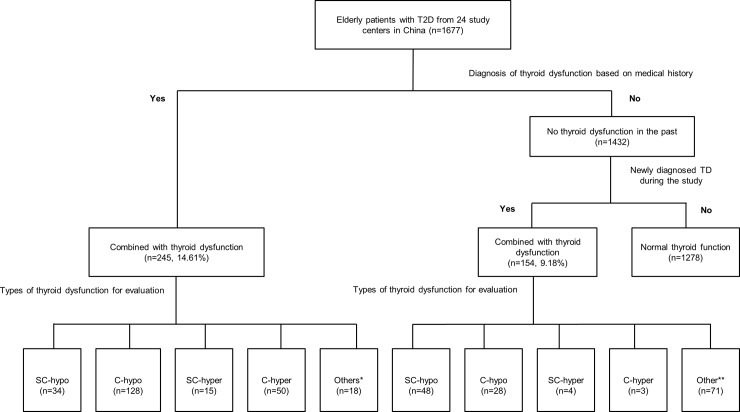
Flow chart showing the distribution of the population with thyroid dysfunction [TD] among elderly Chinese patients with type 2 diabetes [T2D].Patients with a past medical history of thyroid dysfunction [TD]. **Other types of TD such as low T3. C: clinical; SC: subclinical; hypo: hypothyroidism; hyper: hyperthyroidism.